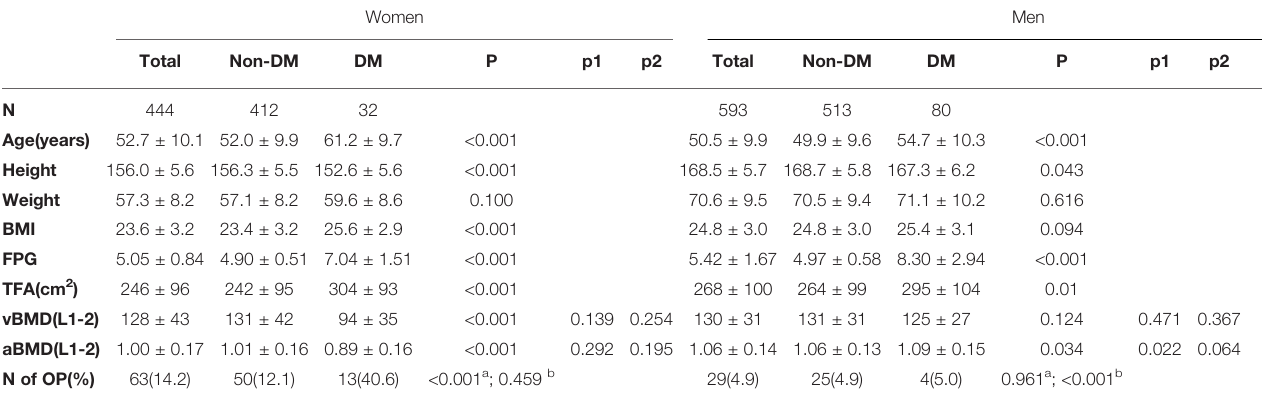
TABLE 2 | Comparisons of participants with DXA-derived aBMD and QCT-derived vBMD between DM and Non-DM in DXA